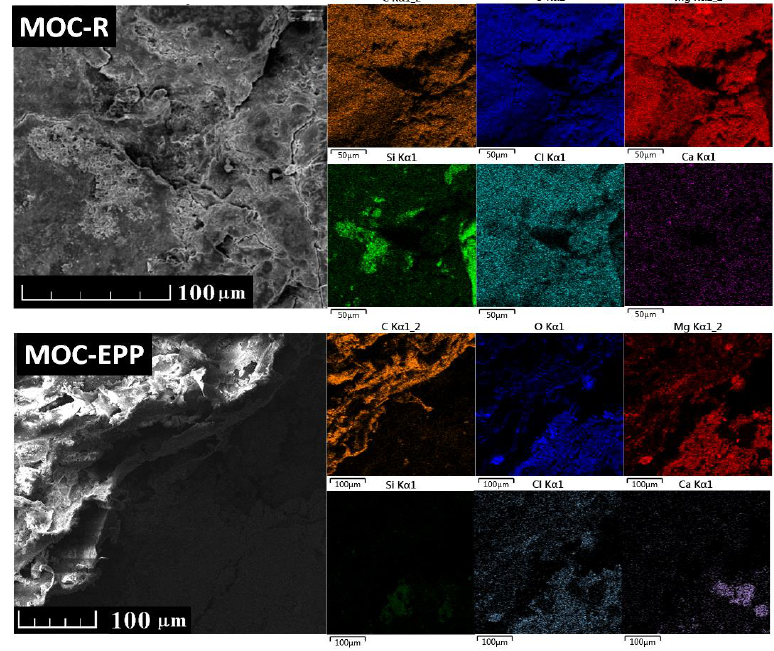
Figure 8. Elemental distribution maps of MOC-R and MOC-EPP obtained by EDS.